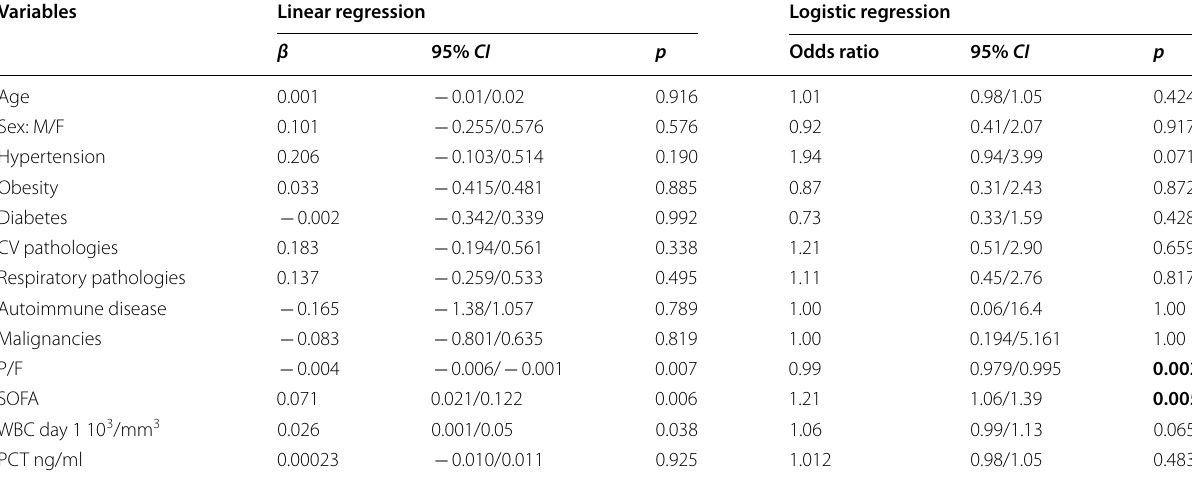
0.003) and SOFA ( p 0.005) = =